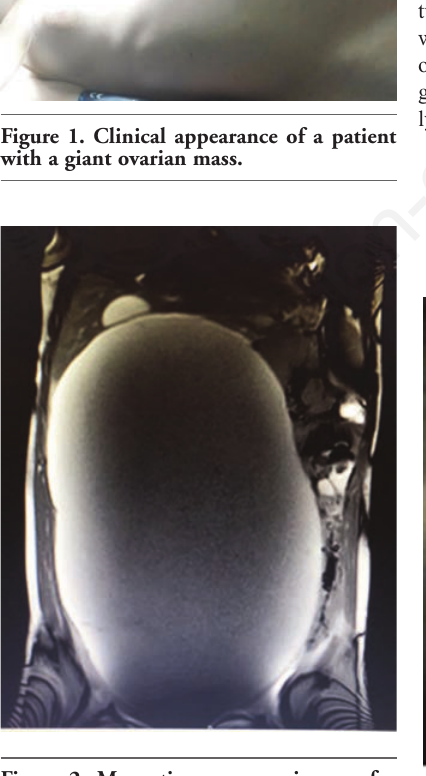
Figure 2. Magnetic resonance image of a giant ovarian mass (coronal view). Figure 3. Insertion of drainage in the cystic component.